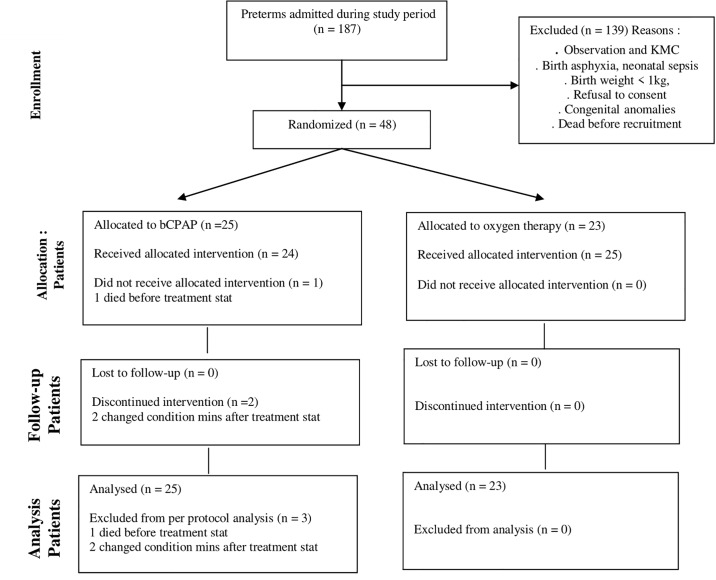
Flow chart showing randomization and treatment allocation of the study participants.